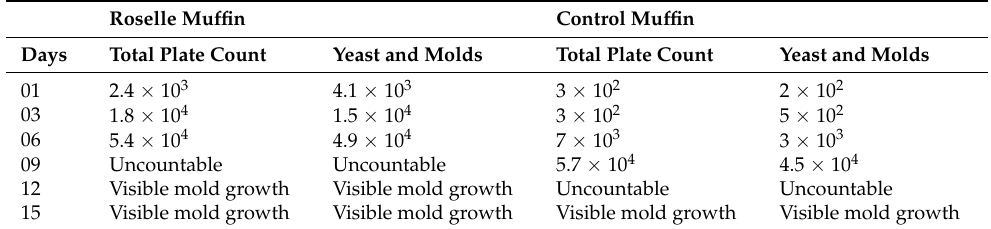
Table 7. Total plate count and yeast and molds during storage of muffins